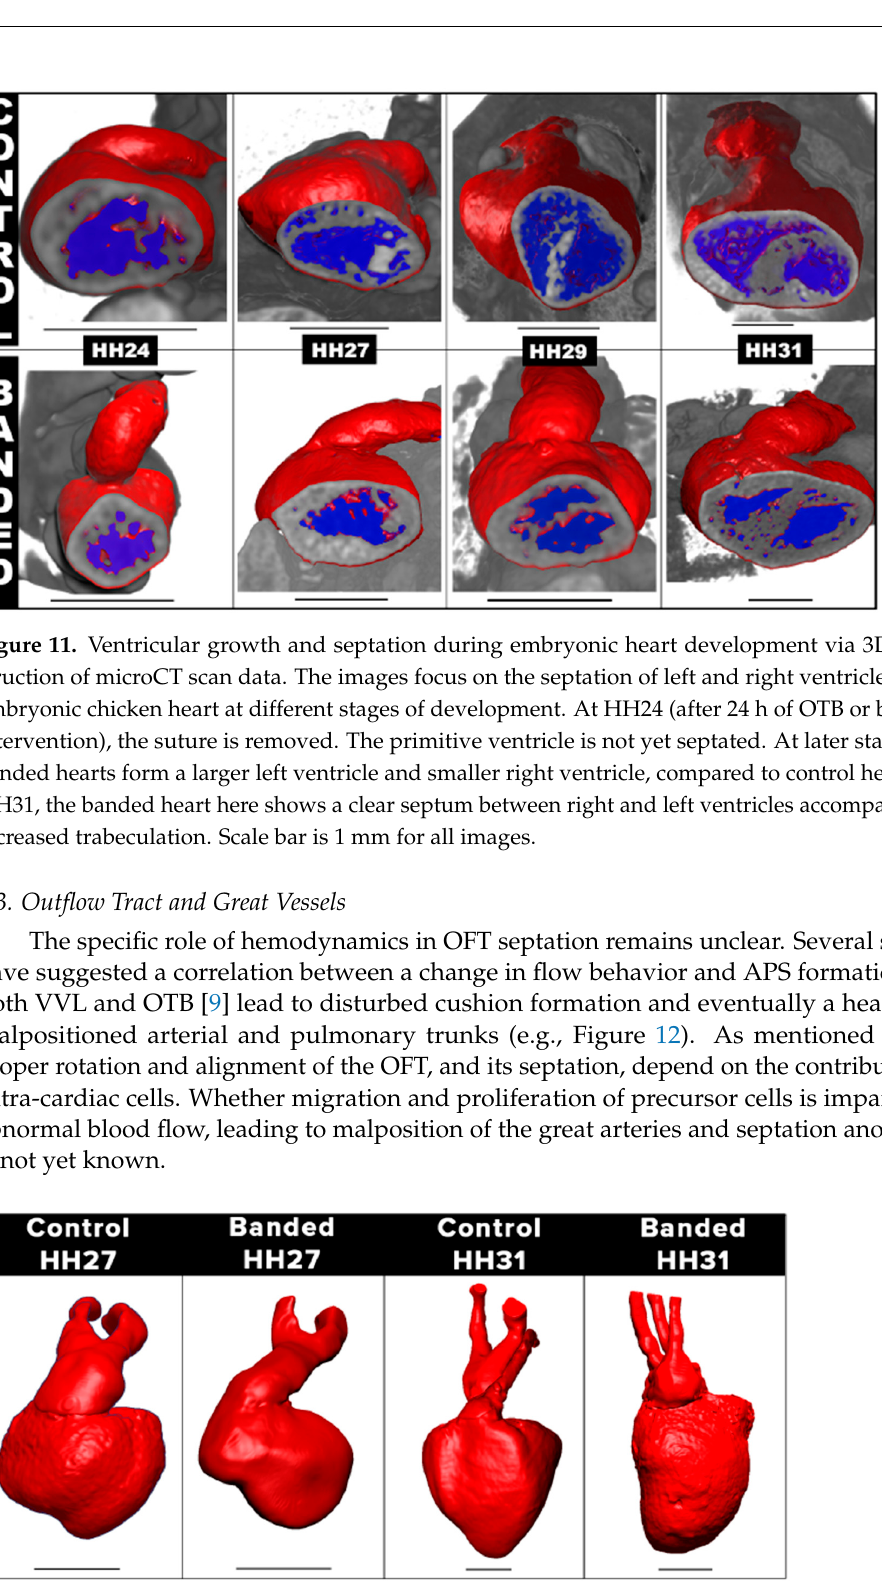
conotruncal banded hearts (OTB); ( c ) left atrial ligation (LAL) hearts. Top (HH29): Compared to the control heart, the OTB heart is more elongated with spiraling trabeculae, while the LAL heart ex- hibits closer packed trabeculae. Stars marks the entry of the conotruncus. Scale bar = 100 µm. Bottom (HH34): Compared to the control heart, the atria of the OTB and LAL hearts are distorted, and ven- tricular proportions changed. Trabecular structures also show a distinct architecture. Scale bar 1 mm. RA: right atrium; LA: left atrium; RV: right ventricle; LV: left ventricle. Reproduced with per- mission from [71].